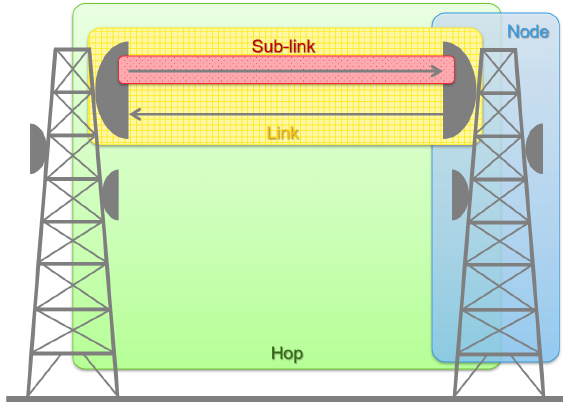
Figure 3. Conceptual representation of a “node”, “sub-link”, “link”, and “hop”, respectively, as used to describe CML network features in this study. One “link” is here equivalent to one